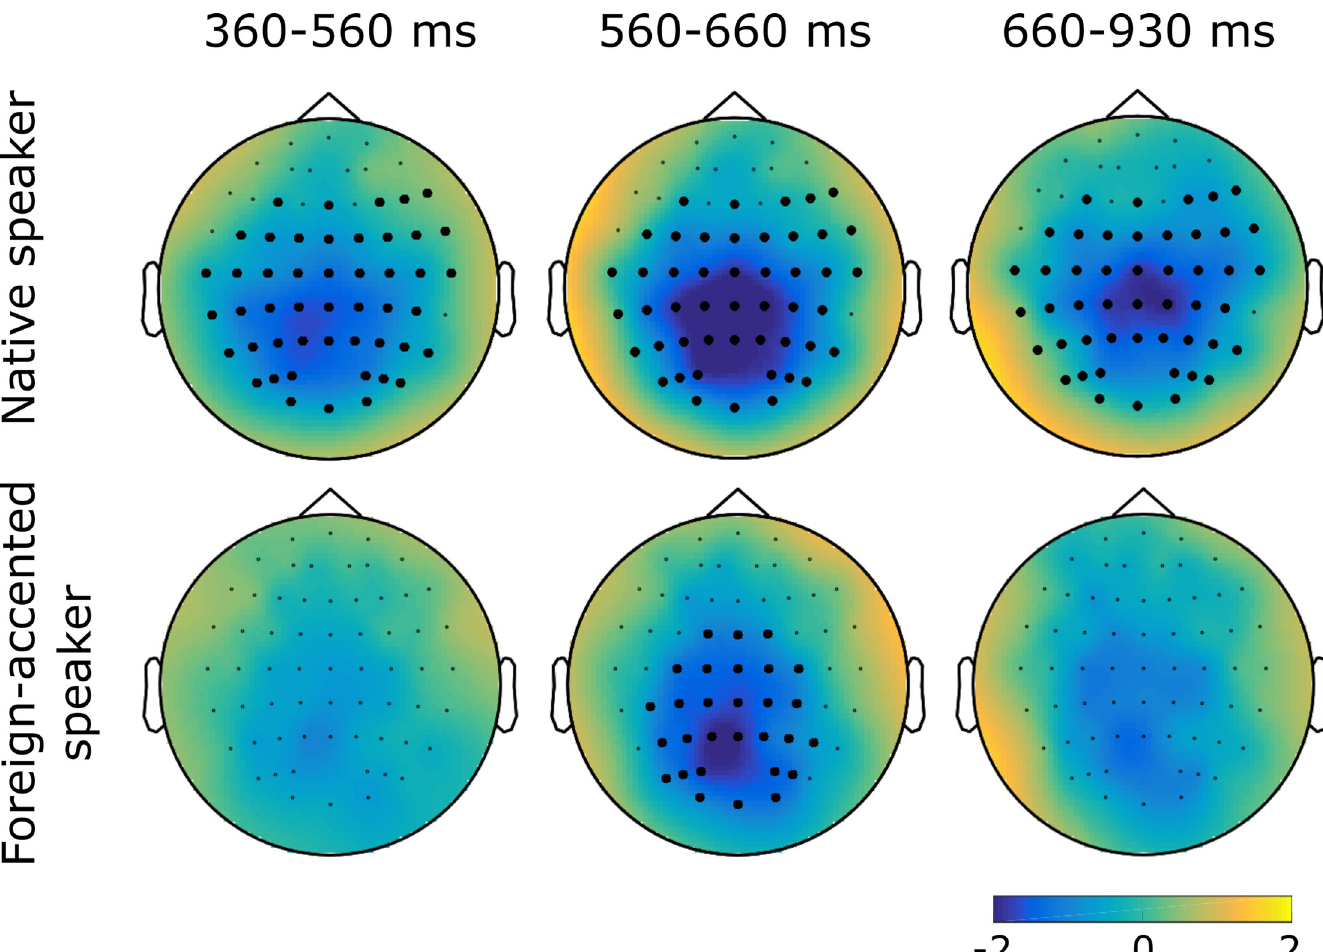
Fig 5. Topographical maps showing the amplitude difference between semantically incongruent and congruent conditions. Native-speaker condition in the top row and foreign-accented-speaker condition in the bottom row. Centre column shows the time period in which the effects temporally overlap. Topographies interpolated from 64 electrodes. Electrodes contributing to the significant effects are shown as filled black